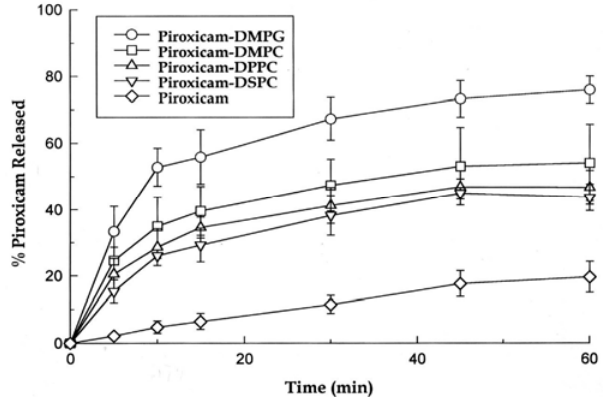
Figure 1. Dissolution profiles of the 10:1 (drug-to-carrier ratio) solid dispersions of piroxicam with various phospholipids in comparison with control piroxicam at 37 ºC in distilled water. Each data point refers to mean ± SD (n = 3).